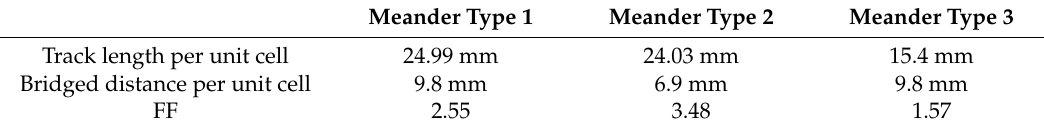
Figure 8. Average, minimum and maximum resistance per bridged cm, per type of meander. Table 5. Relevant geometrical parameters related to the electrical properties of the meanders.